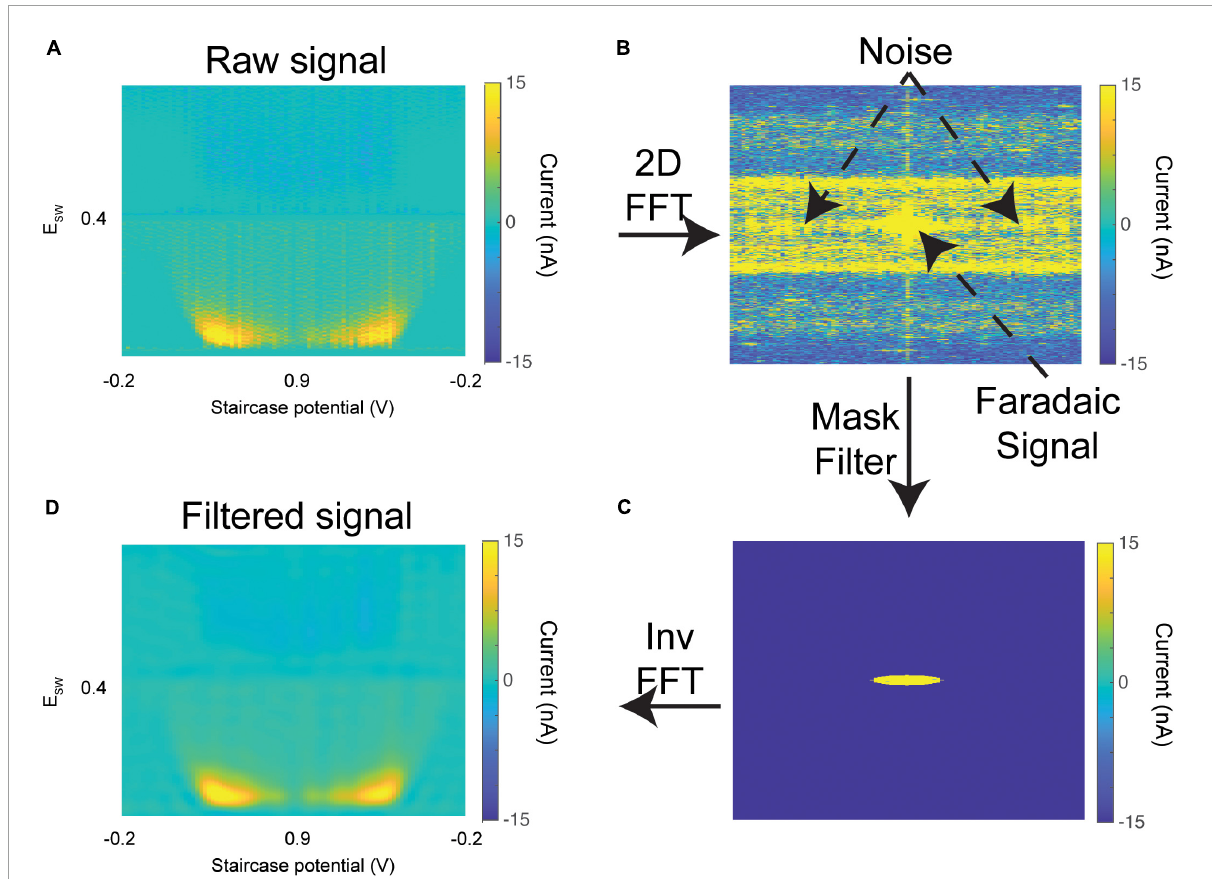
FIGURE5 Mask filter. (A) Raw 3-D color plot of dopamine oxidation currents (similar to Figure 4E ) from an in vivo experiment. (B) 2-D Fast Fourier transform of the raw color plot, with low frequencies shifted to the center. (C) An elliptical mask filter is applied which zeros out all contributions outside its boundary. (D) Inverse 2-D Fast Fourier transform to recover the color plot. The oxidation currents are preserved, while noise was effectively filtered